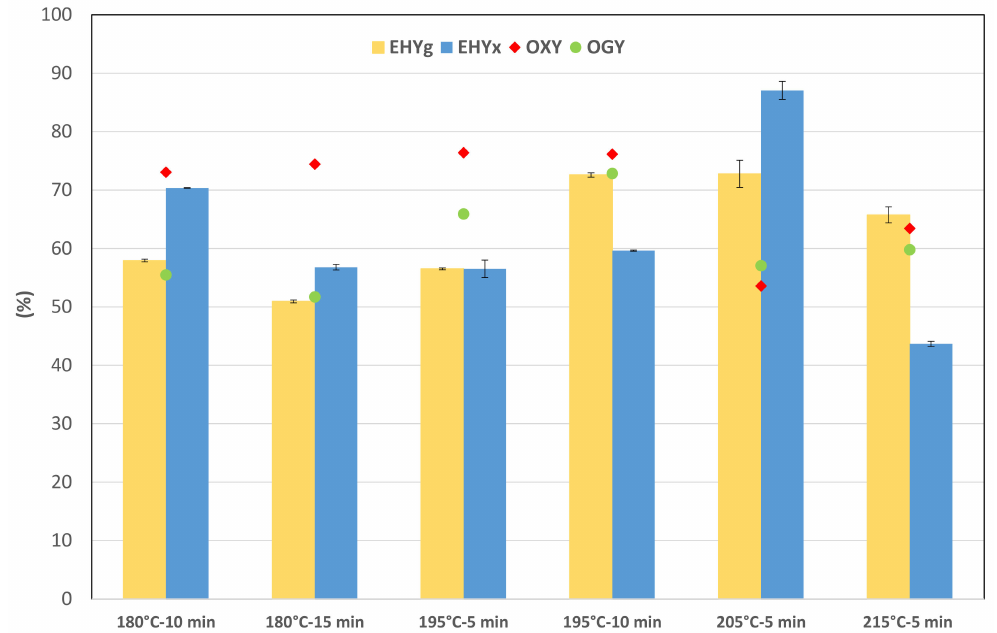
Figure 3. Enzymatic hydrolysis glucan (EHYg) and xylan (EHYx) yields and overall glucose (OGY) and xylose (OXY) yields from WIS obtained at di ff erent DA-SE pretreatment conditions. Based on di ff erent parameters evaluated, DA-SE combinational pretreatment carried out at a ◦ temperature of 195 C for 10 min was selected for MFGW biomass for the study of the e ff ect of solid content and enzyme loading in enzymatic hydrolysis